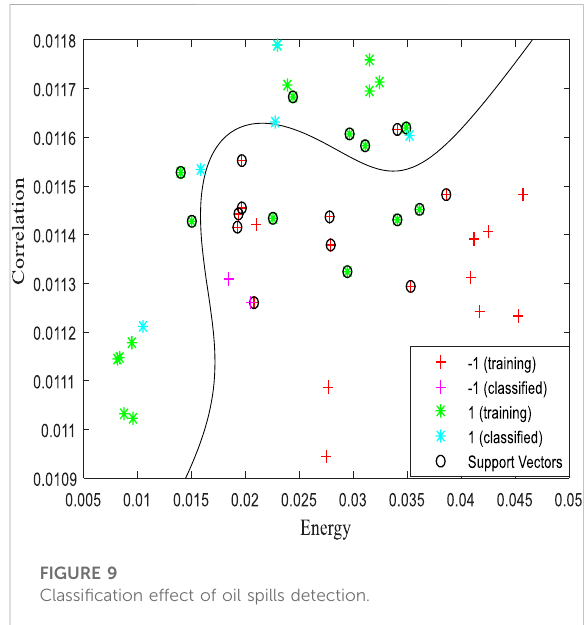
FIGURE 9 Classi fi cation effect of oil spills detection.